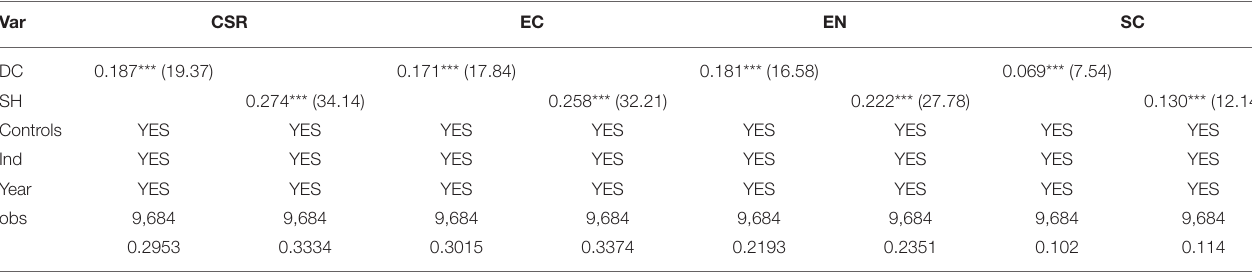
TABLE A1 | Results of standardized regression analysis for corporate network position and CSR. Var CSR EC EN SC DC 0.187*** (19.37) 0.171*** (17.84) 0.181*** (16.58) 0.069*** (7.54) SH 0.274*** (34.14) 0.258*** (32.21) 0.222*** (27.78) 0.130*** (12.14) Controls YES YES YES YES YES YES YES YES Ind YES YES YES Year YES YES YES YES YES YES YES YES obs 9,684 9,684 9,684 9,684 9,684 9,684 9,684 9,684 0.2953 0.3334 0.3015